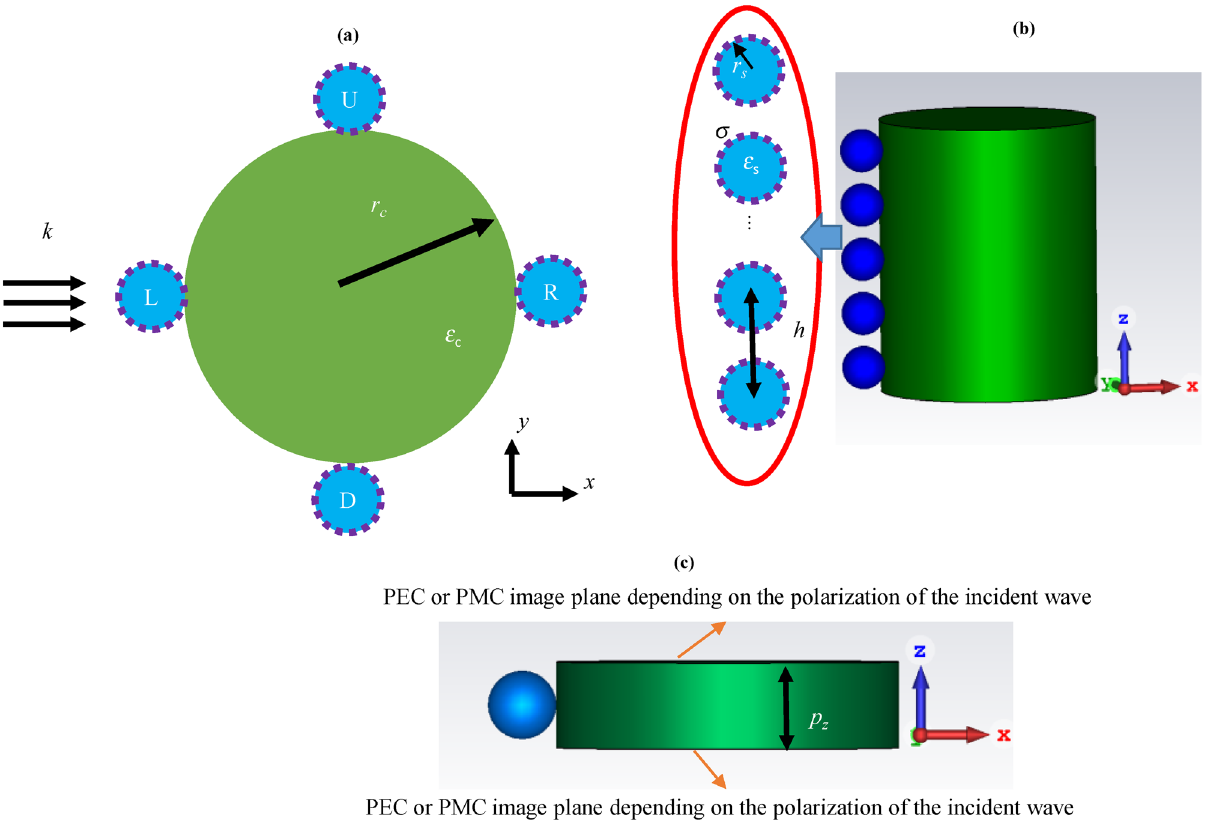
Figure 1. A longitudinally infinite one-dimensional array constructed by the graphene-coated hollow spherical nanoparticles wrapped around a dielectric cylinder, on the possible positions of R (Right), L (Left), U (Up), or D (Down) with respect to the incident wave ( a ) 2D and ( b ) 3D views. When the nanoparticles located at two of the labeled positions are considered simultaneously the double one-dimensional periodic array is attained. ( c ) The 3D view of the simulated unit cell for the L position. In simulations, the periodicity along the cylinder axis is implemented via the image theory.